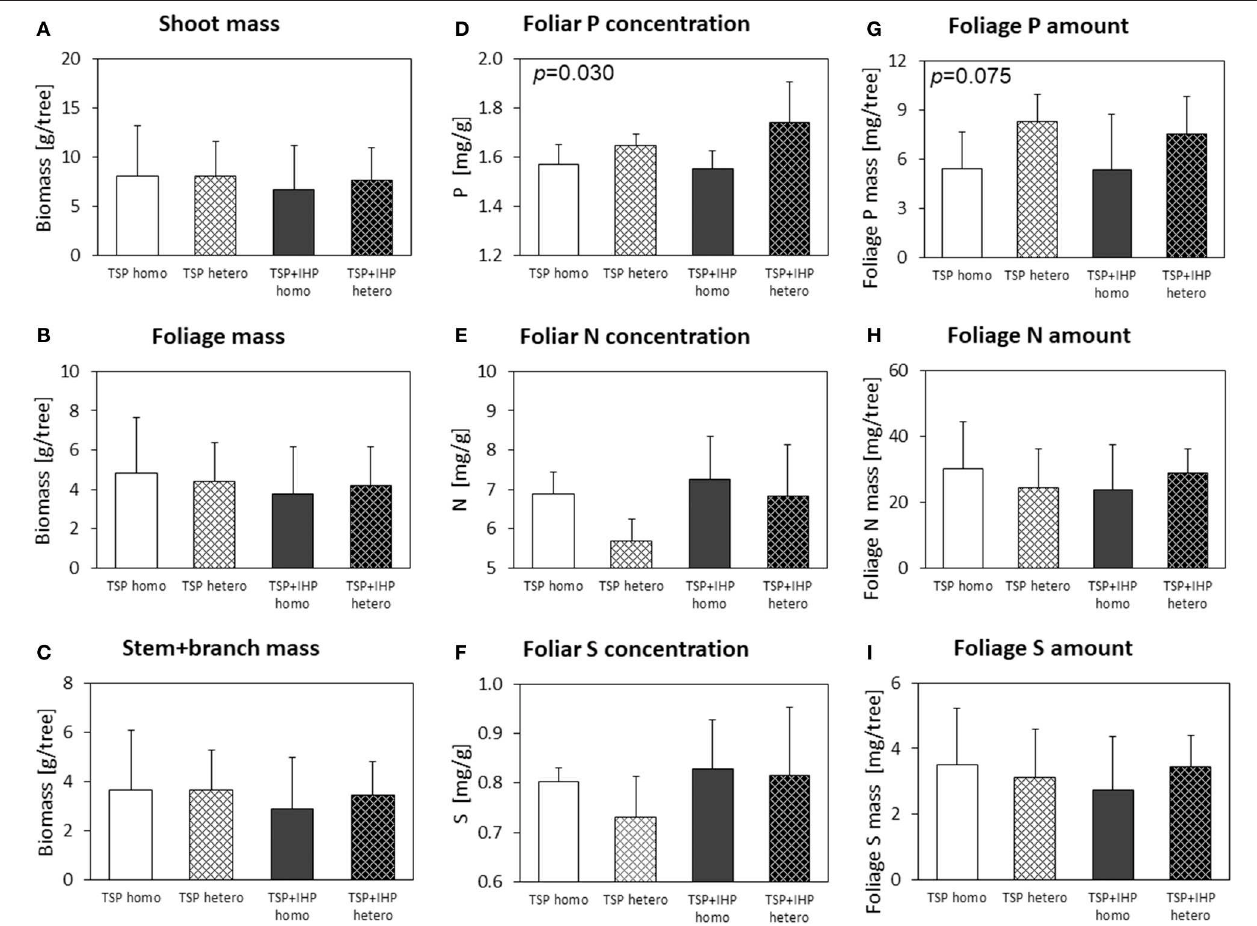
FIGURE 7 | Shoot (A) , foliage (B) , and stem + branch (C) biomass, foliar concentrations of N (D) , P (E) , and K (F) , and nutrient (P, N, K) amounts in foliage (G–I) of Picea abies at the moderate-P silicate site. Numbers in the upper left panel corner show p < 0.1 for differences between mean values of homogeneous vs. heterogeneous P application calculated by one-way